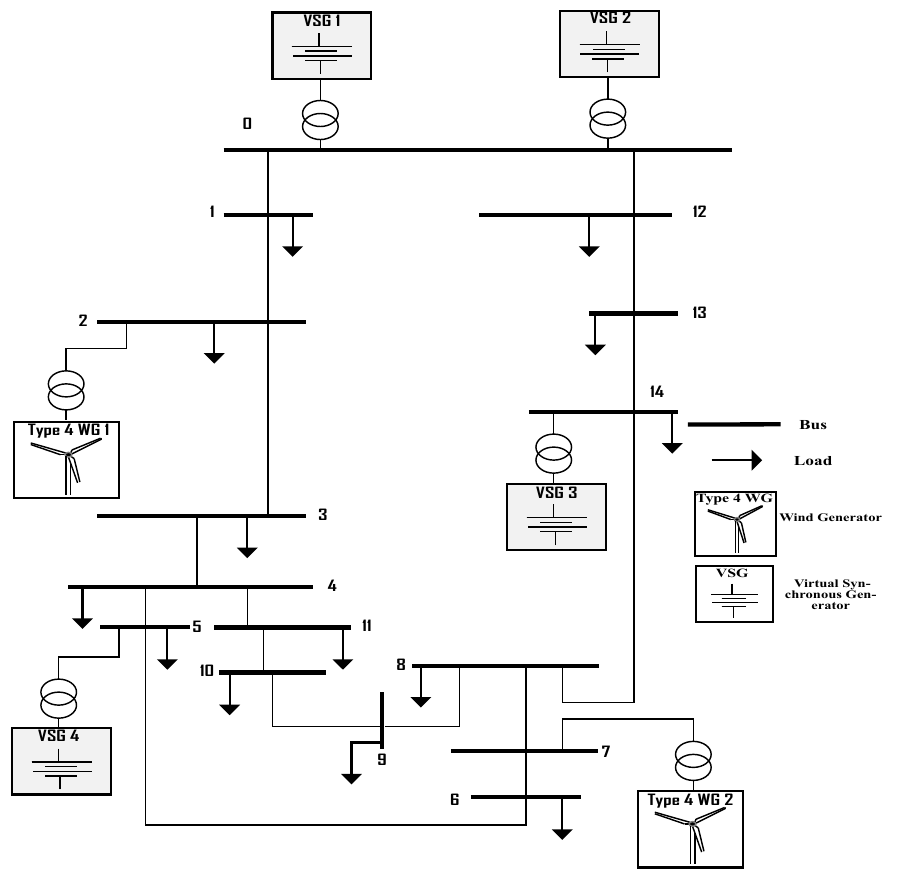
Figure 13. Modified CIGRE benchmark test microgrid (Reprinted/adapted with permission from Ref. [18]. 2021,